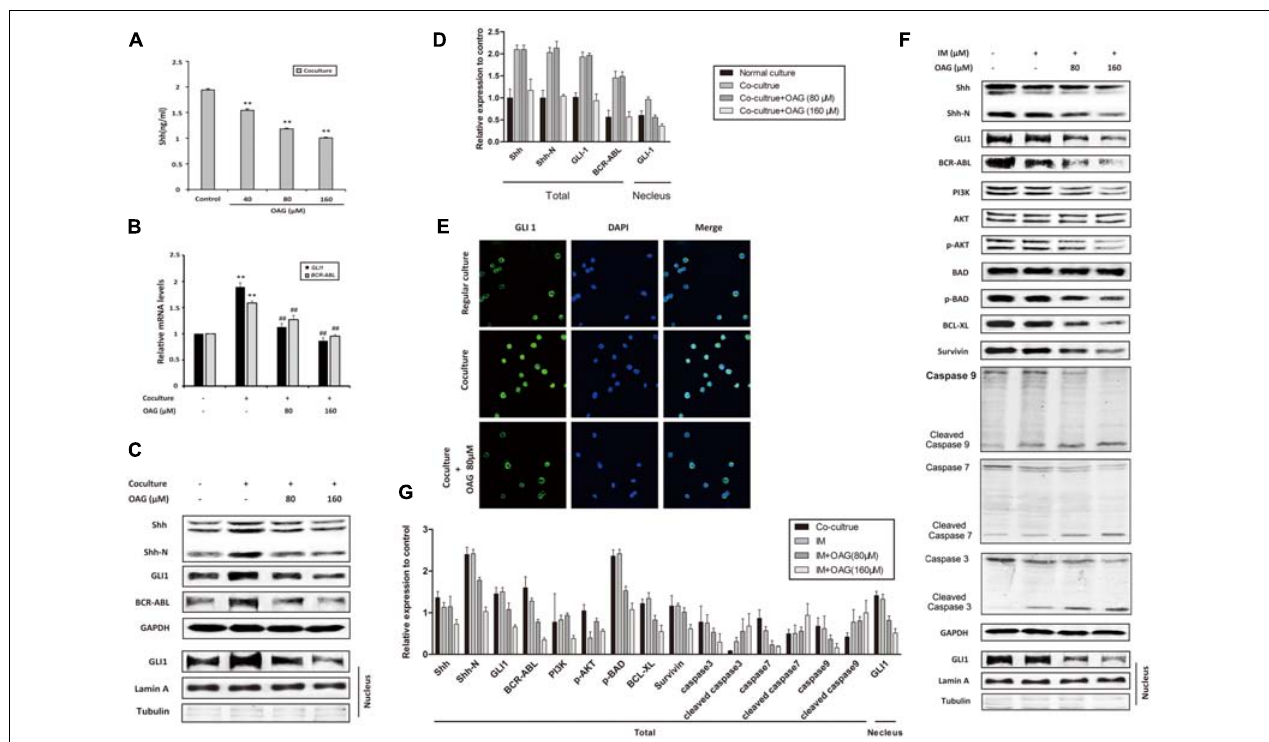
FIGURE 4 | Oroxyloside A inhibited hedgehog pathway and down-regulated BCR-ABL in co-culture system. (A) Cells were co-cultured for 24 h and then treated with OAG for another 36 h in a dose-dependent manner. After that, culture supernatants were collected and subjected to ELISA to detect Shh secretion ( ∗∗ p < 0.01 compared with control). (B–E) Regular cultured and co-cultured K562 cells were treated with OAG as indicated. Real-time PCR, western blot and Immunofluorescence were performed for analysis of GLI1 and BCR-ABL mRNA expression (B) , Shh, Shh-N, total GLI1, BCR-ABL (C,D) and nuclear GLI1 localization (E) ( ∗∗ p < 0.01 compared with regular co-culture and ## p < 0.01, # p < 0.05 compared with control in co-culture). (F,G) Co-cultured cells were treated with IM alone or combined with OAG for 36 h as indicated. The whole lysates and nuclear extract were subjected to western blot for evaluating Hh pathway and canonical apoptosis pathway related proteins, as well as nuclear GLI1 expression. GAPDH was used as total protein control, whereas Lamin A and Tubulin was used for evaluating nuclear fractionation